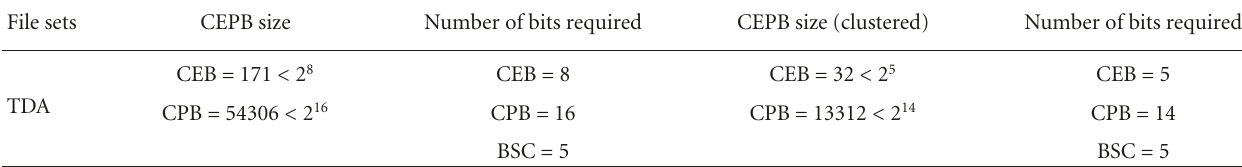
Table 9: Bit allocation table for the second group of experiments.